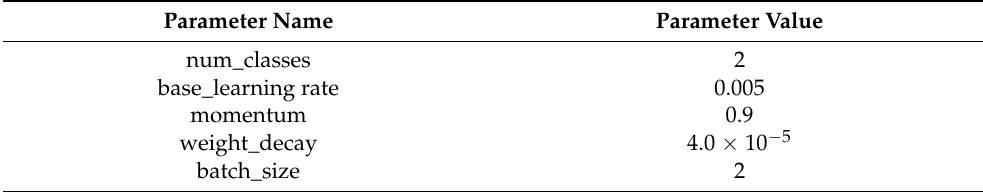
Table 2. Configuration of key parameters of lesion segmentation module in MVI-Mind framework.